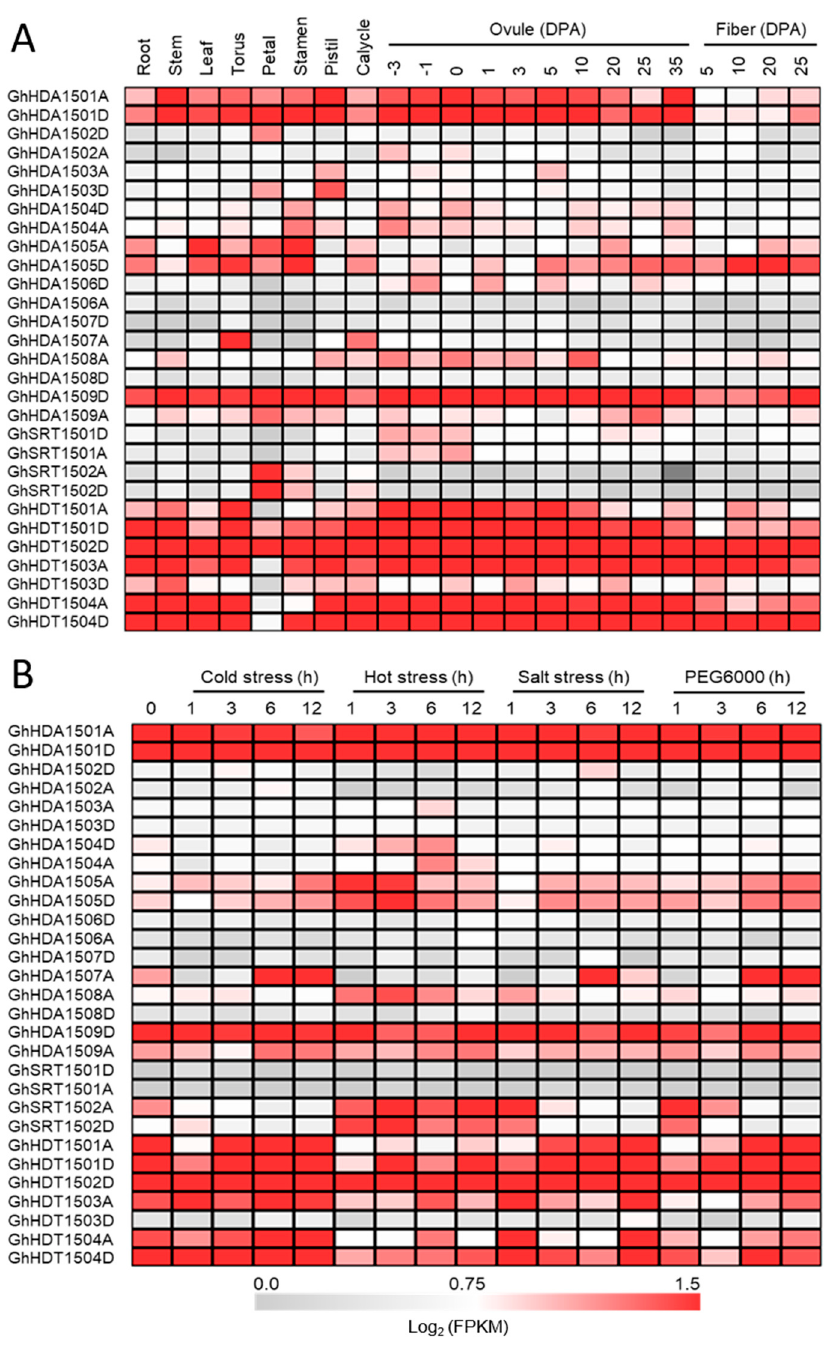
Figure 4. Gene expression analysis of G. hirsutum HDACs in different tissues and at different stages of fiber development ( A ), and in response to cold (4 °C), heat (38 °C), salt (400 mM), and PEG 6000 (20%) stress ( B ) from RNA-seq. The illumina reads of RNA-seq data were retrieved from the NCBI SRA database. The color scale on the bottom of the heatmap indicates the FPKM (Fragments Per Kilobase of transcript per Million mapped reads)-normalized log2 transformed counts. DPA: days post anthesis.